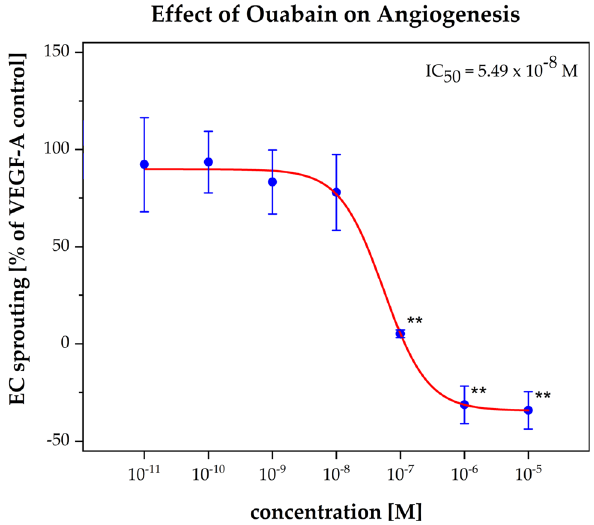
Fig. 6 Effect of angiogen- esis. The VEGF-A induced HUVEC spheroid sprouting (% of VEGF-A control) was plotted as the function of the Ouabain concentration (10 –12 to 10 –5 M). The red curves represent the nonlin- ear regression analysis for the IC calculation. The angio- 50 genesis effect was observed by IC = 2.30 × 10 –6 M. Error 50 bars show the range of meas- ured values of each duplicate and the level of significance is shown by the p-value range ( * p < 0.05 and ** p <